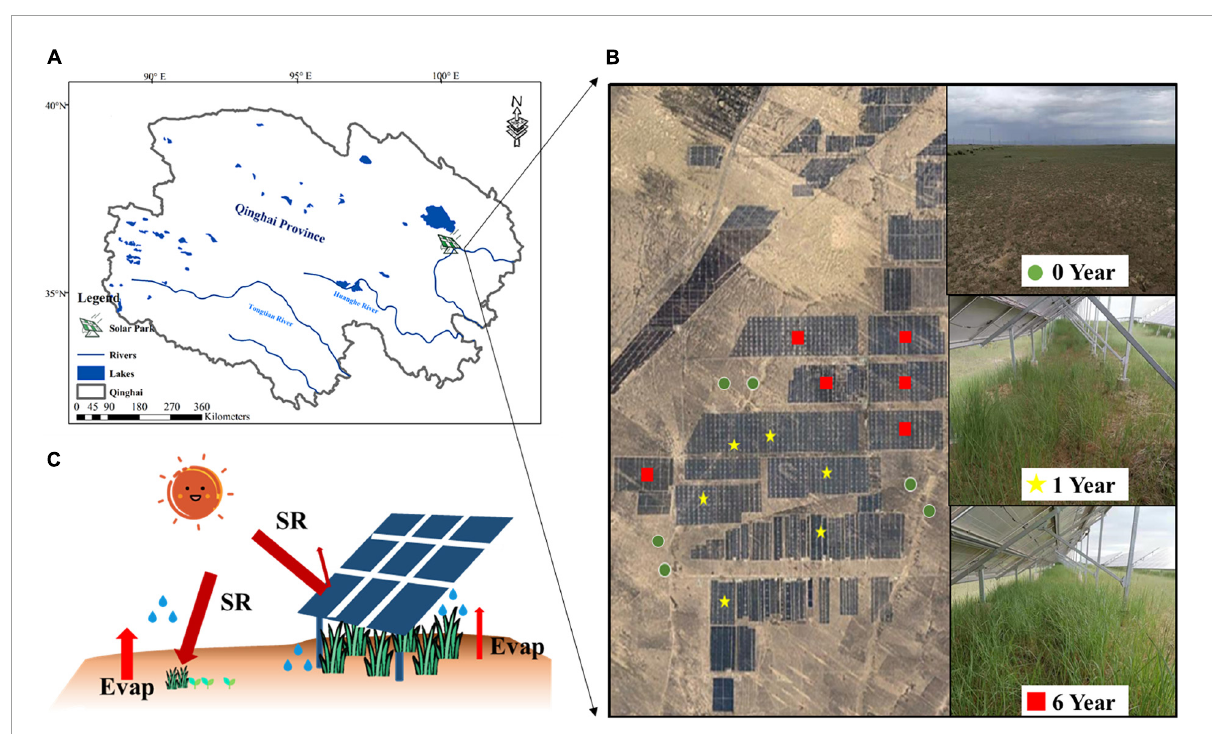
FIGURE1 Location of solar park (A) , image of sample sites (B) , and schematic of the potential effects of photovoltaic panel on microclimate (C)